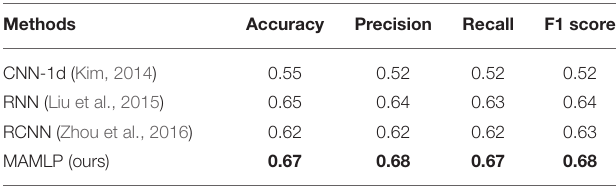
TABLE 5 | Data summary of in Alzheimer’s disease (AD)/mild cognitive impairment (MCI)/normal control (NC) classification. Methods